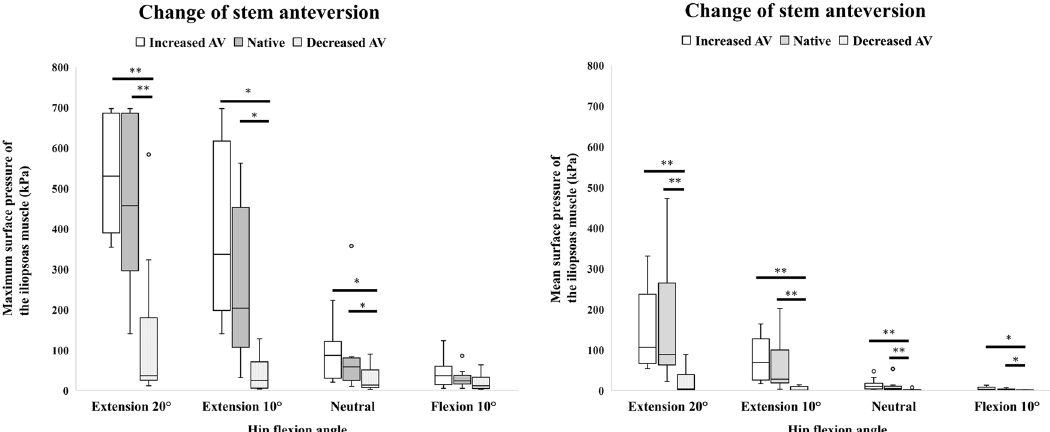
Figure 3. Maximum and mean surface pressure of the iliopsoas muscle when the stem anteversion (AV) was changed. * p < 0.05, ** p < 0.01.